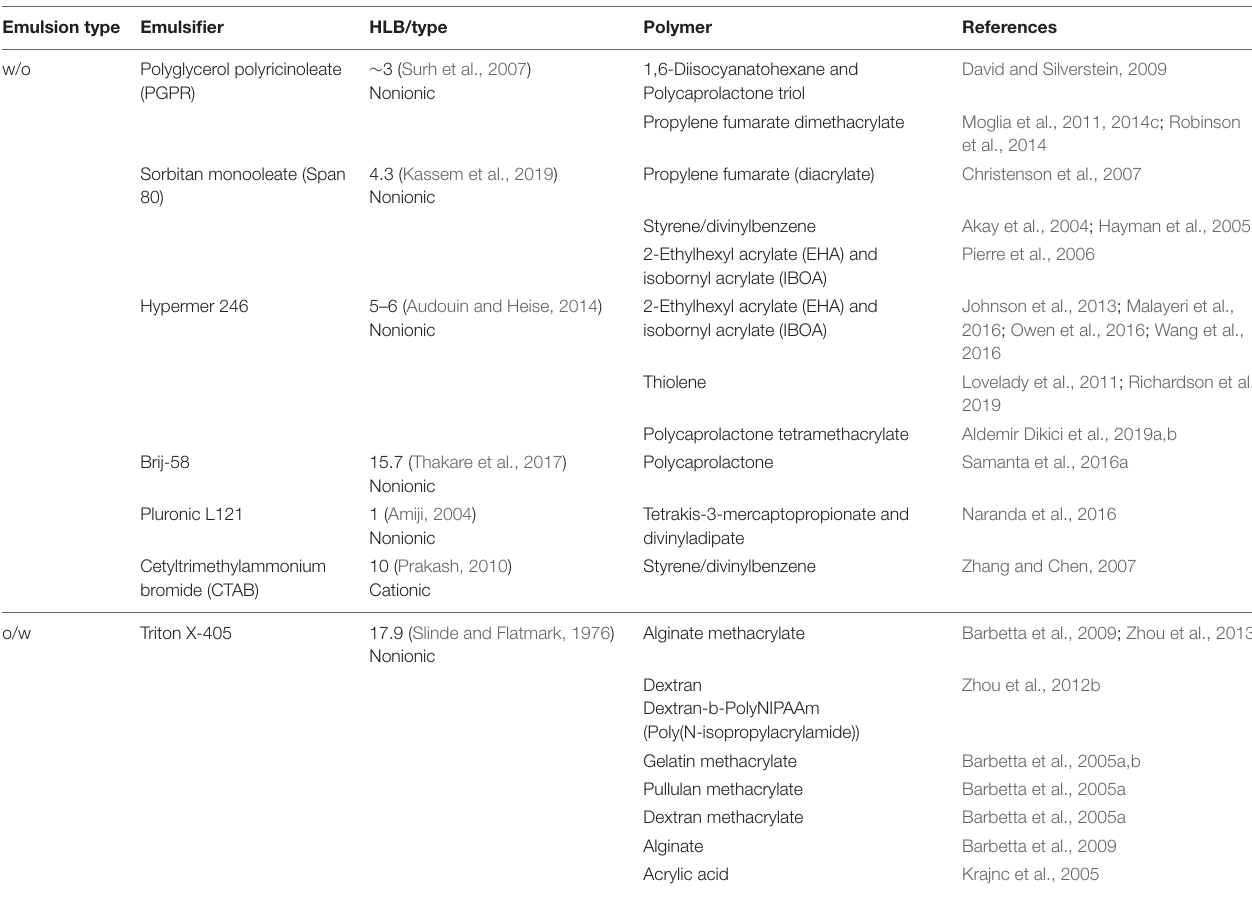
TABLE 1 | Commonly used surfactants in HIPEs of various polymer